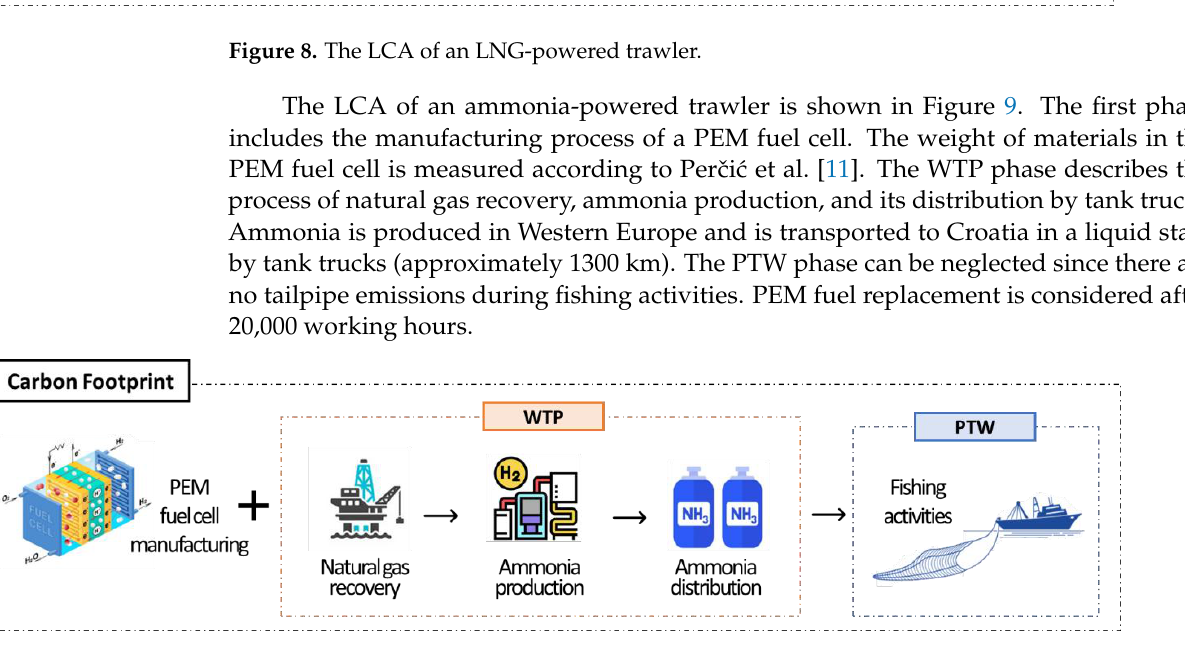
Figure 9. The LCA of an ammonia-powered